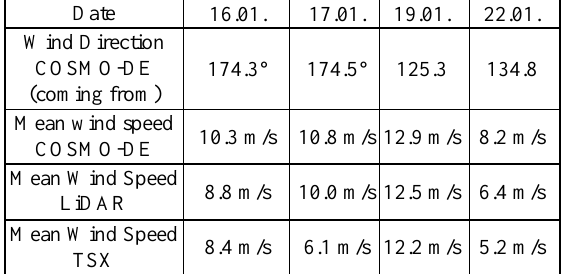
Figure 6. Comparison of 10 m wind fields from COSMO- DE and TS-X. Mean difference (height of column) and Table 2. Overview of characteristic wind parameters at 10m standard deviation of the difference (error bars) are height for model and shown.